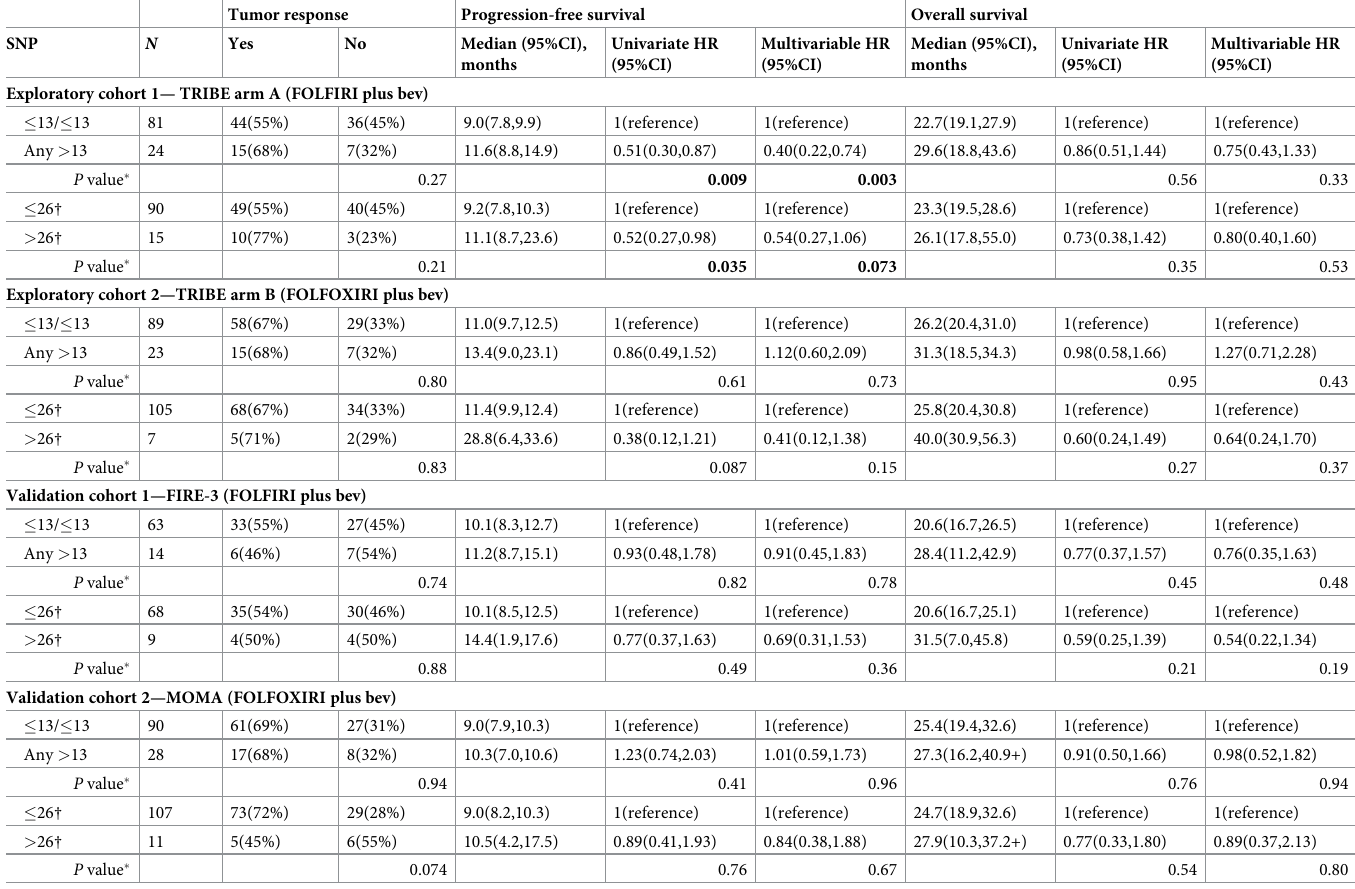
Table 4. Associations between CCTTT repeats and outcomes in RAS mutant